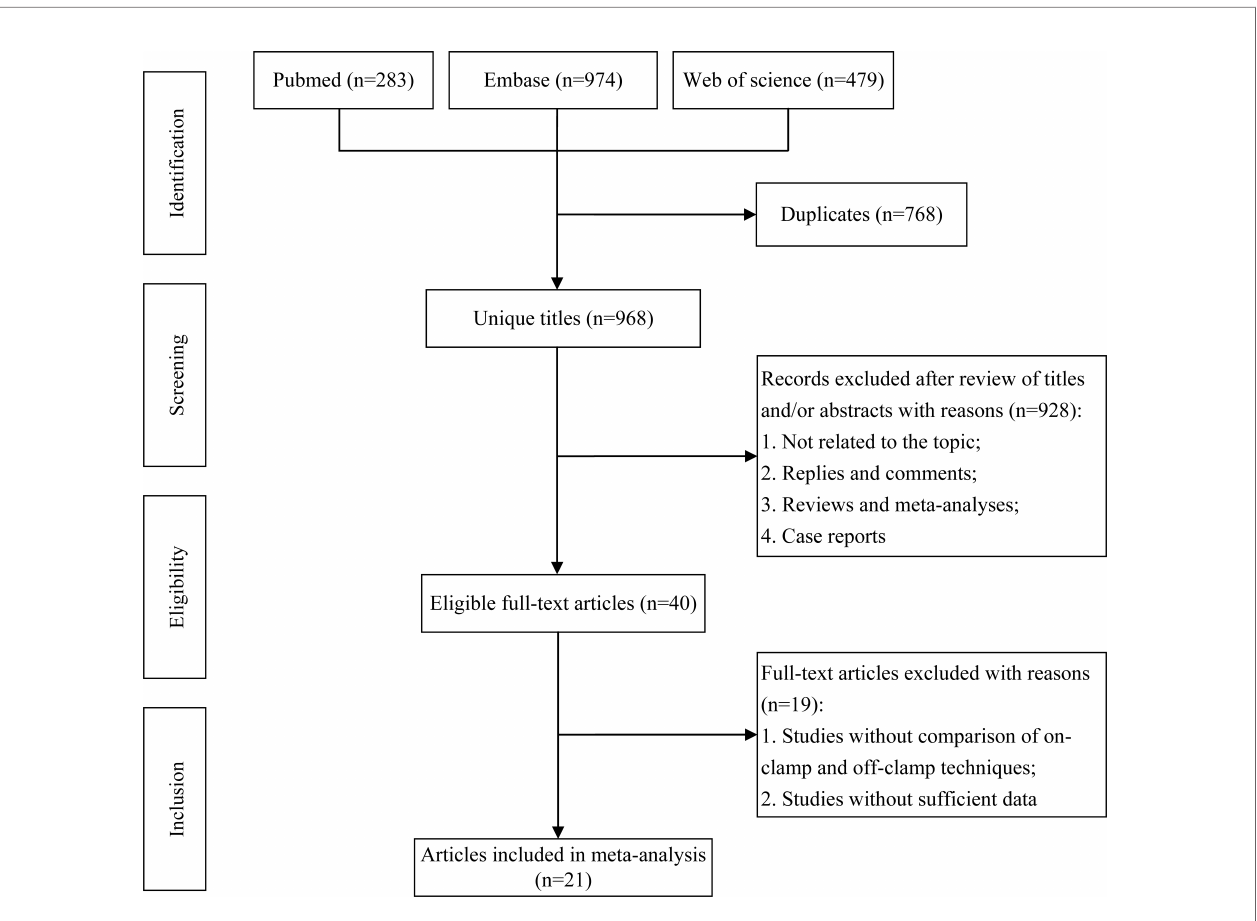
FIGURE 1 | Flowchart of the systematic search and selection